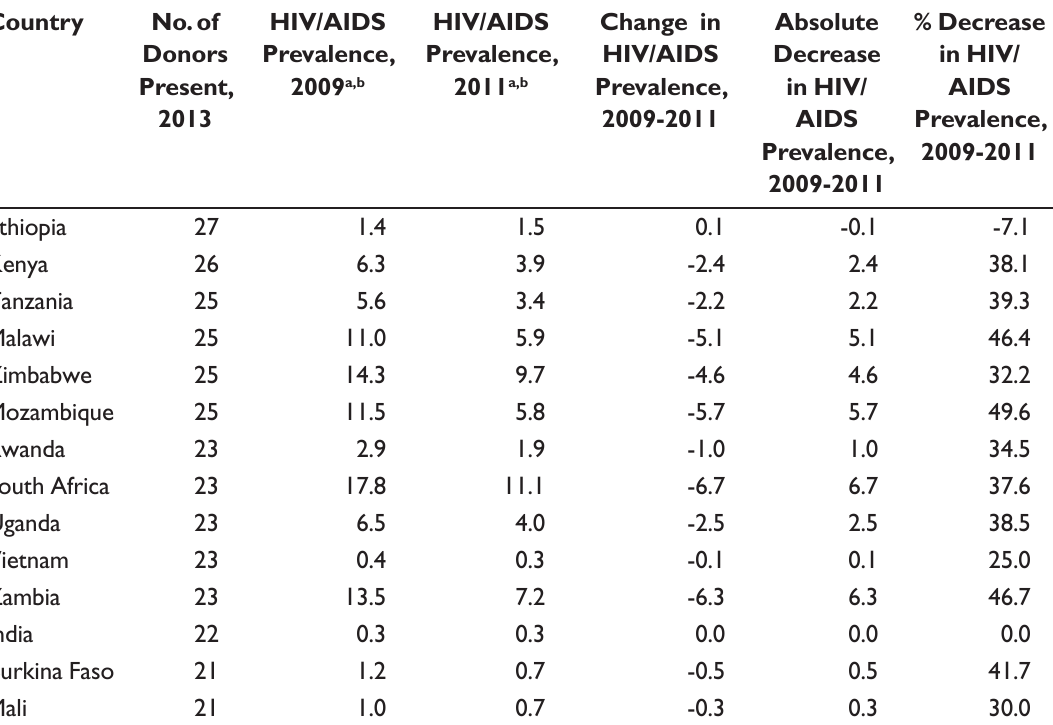
Donor Presence and Changes in HIV/AIDS Prevalence in Developing Countries, 2009-2011 Country No. of